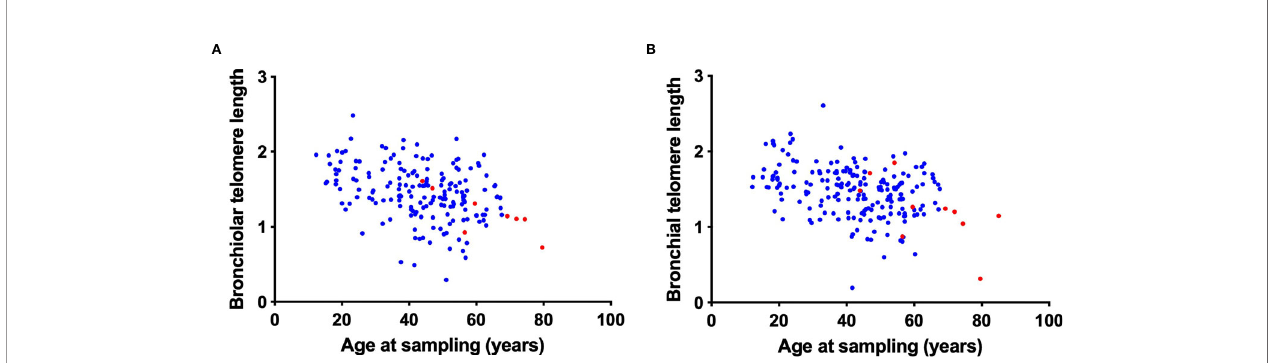
FIGURE 2 | Correlation of bronchiolar and bronchial airway telomere length with donor age. Bronchiolar (A) and bronchial (B) airway telomere length (relative T/S ratio, arbitrary units) are plotted against the age at sampling for transplant recipients (blue). Age at sampling was calculated as the sum of donor age and time post- transplant at sampling. Control airway telomere length (red) are plotted against age at